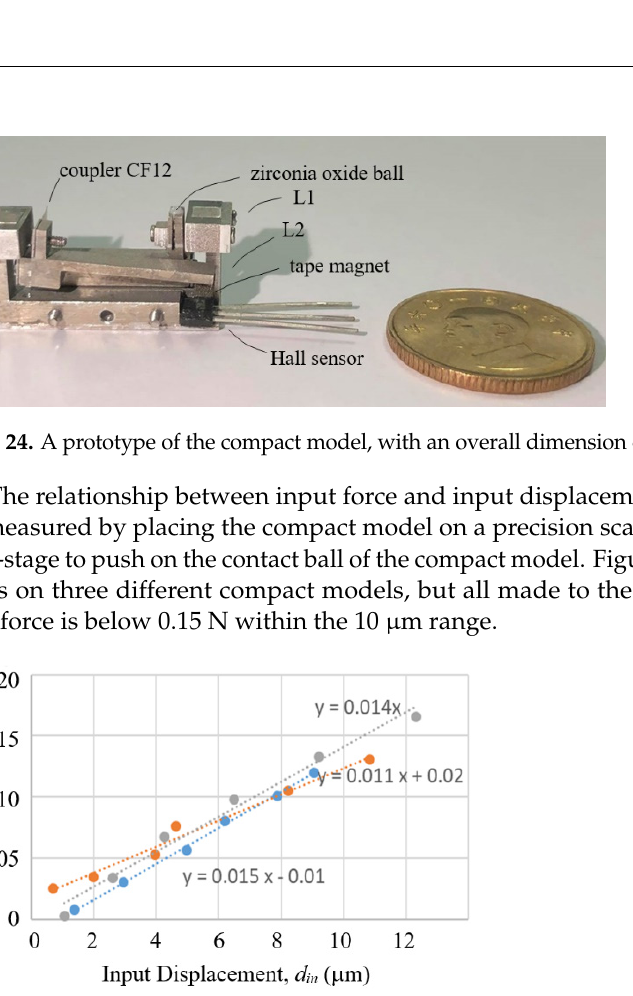
Figure 25. Input force in relation to input displacement of the compact model measured from three different prototypes of the compact model.